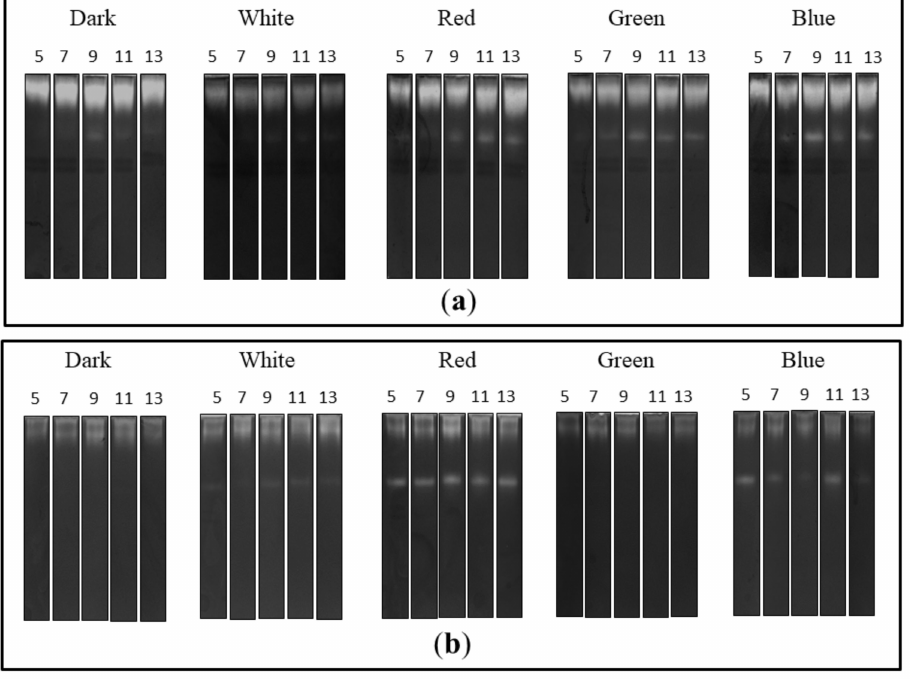
Figure 3. Zymograms of the activity of extra- ( a ) and intracellular ( b ) C. unicolor proteases detected in acid conditions during fungus growth in the dark (control), white, red, green and blue lighting conditions; for each light variant, the number of days of C. unicolor cultivation, after which the zymographic analyses were performed, is indicated.